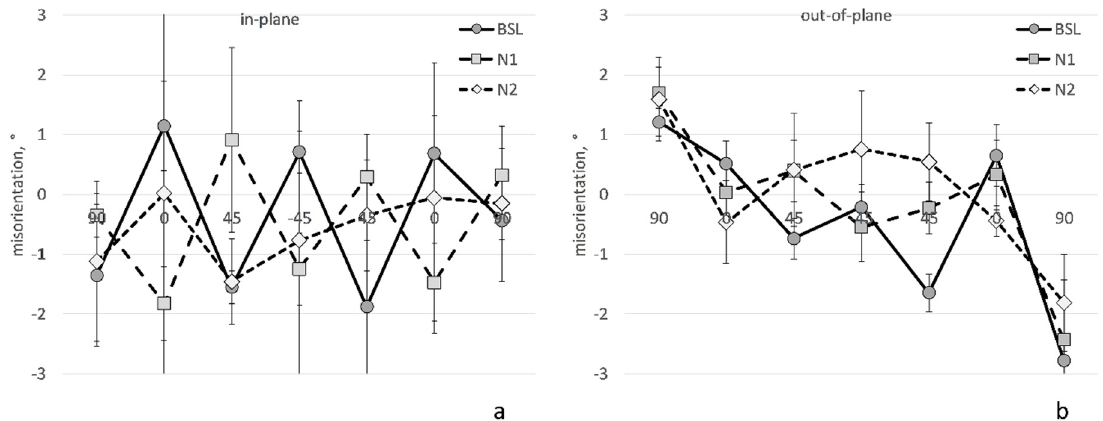
Figure 7. Misorientation of plies: ( a ) in-plane; ( b ) out-of-plane. Horizontal axis enumerates values of the nominal ply orientations. Error bars are standard deviations in four 3D images.